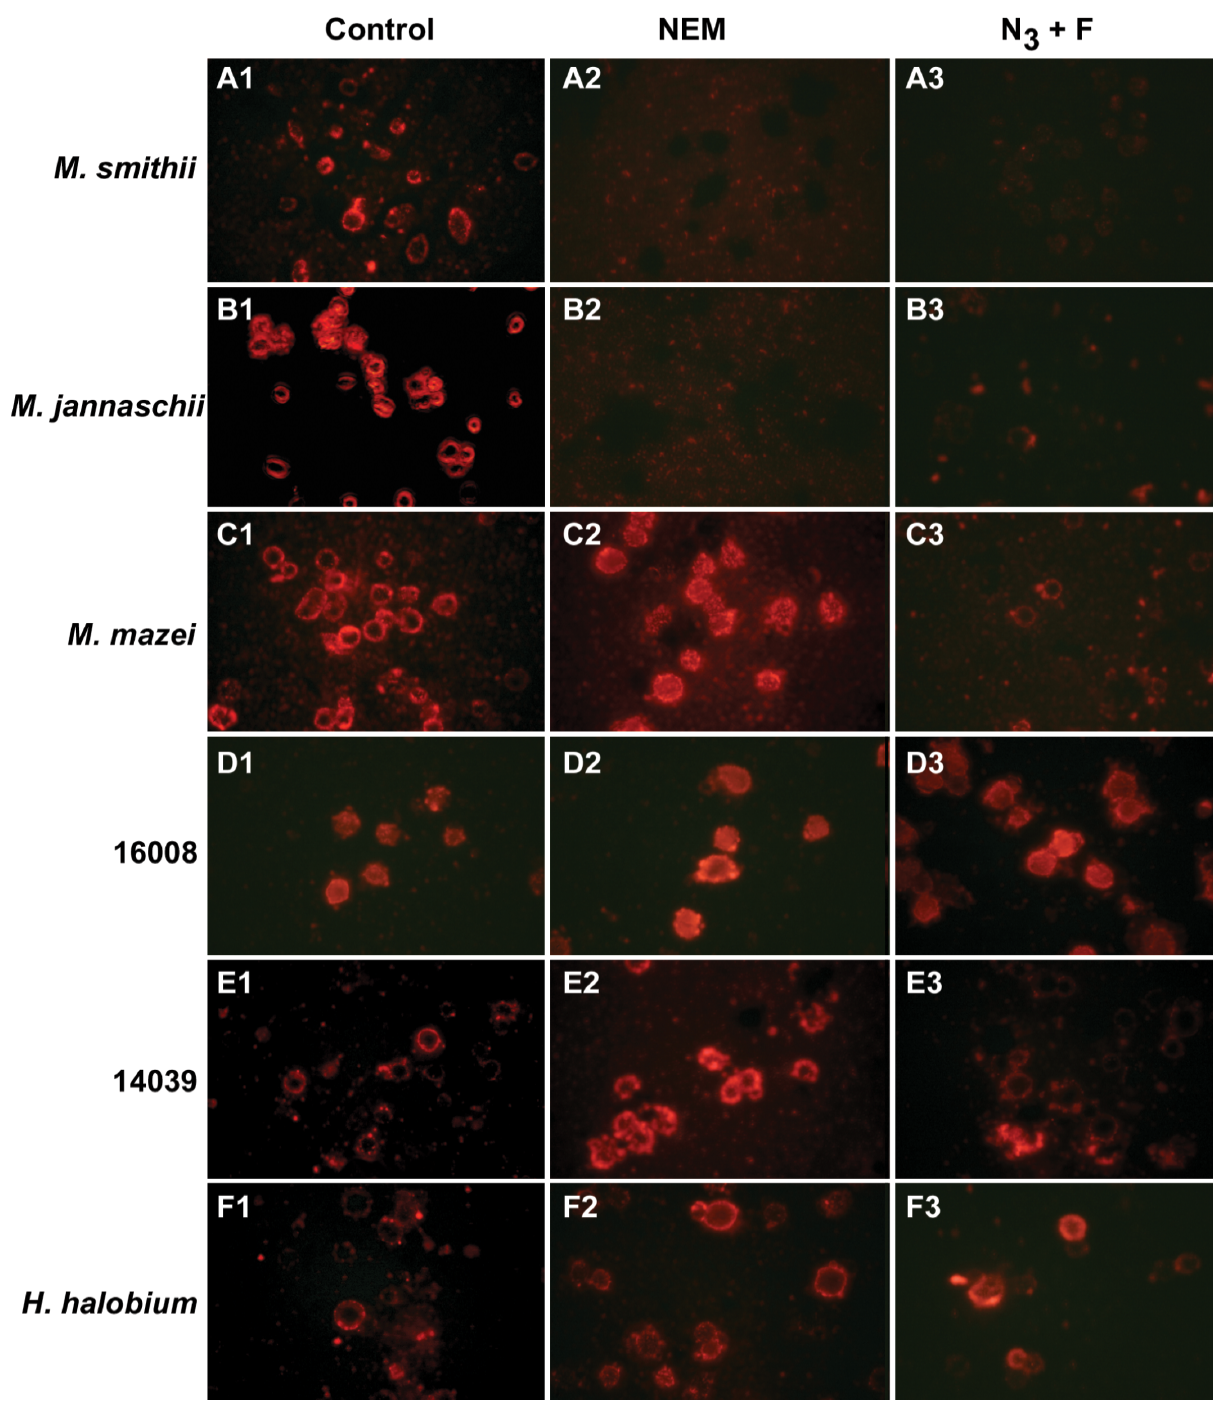
Figure 7. Inhibition of macrophage-mediated uptake of rhodamine-labeled archaeosomes by N-ethylmaleimide and azide plus fluoride. N-ethyl- maleimide (10 mM) or NaN 3 plus NaF (15 mM each) in RPMI were added to adherent thioglycollate-activated peritoneal macrophages for 15 min. Uptake was then initiated by adding 25 µg of rhodamine-labeled archaeosomes. Reactions were stopped with 1% formaldehyde after 60 min, with the exception of panels A and F where uptake was stopped after 15 min. Rhodamine-labeledarchaeosomes of total polar lipids of (A) M. smithii , (B) M. jannaschii , (C) M. mazei , (D) H. morrhuae strain 16008, (E) H. morrhuae strain 14039 and (F) H. halobium . Panel 1, no inhibi- tor; Panel 2, N-ethylmaleimide; and Panel 3, azide plus